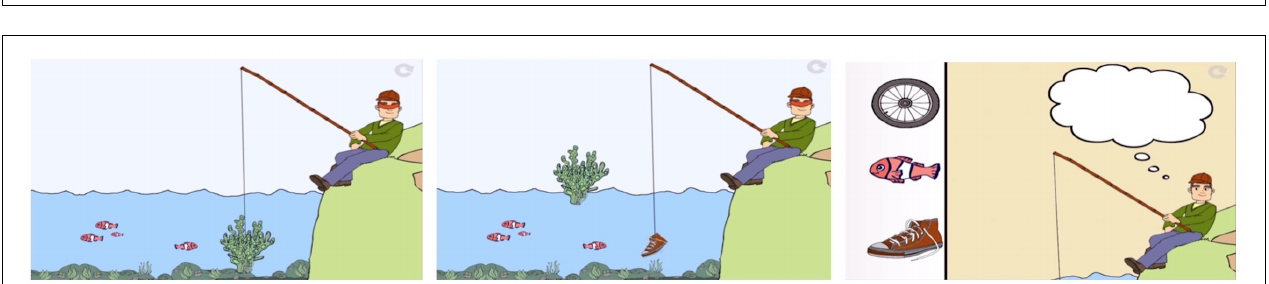
FIGURE 2 | Illustration of the verbal ToM task.